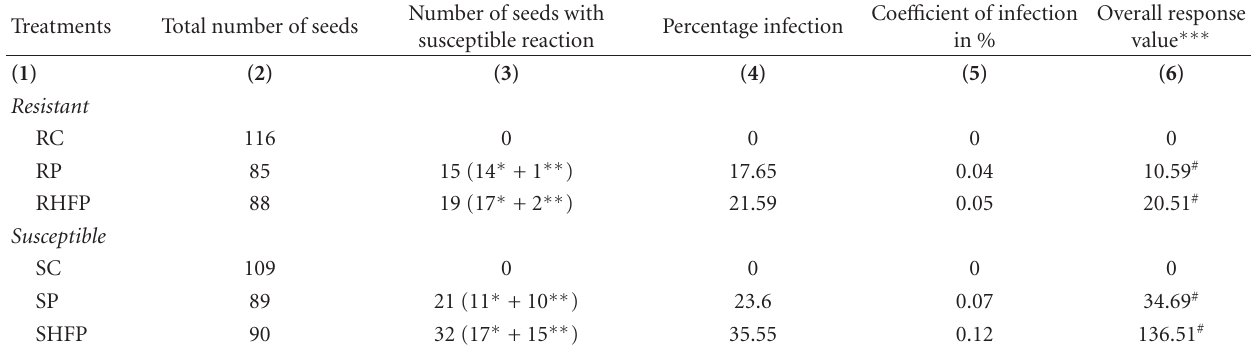
Table 1: Pathogenicity testing of two varieties under di ff erent treatments on the basis of disease scoring after the crop harvest. Treatments